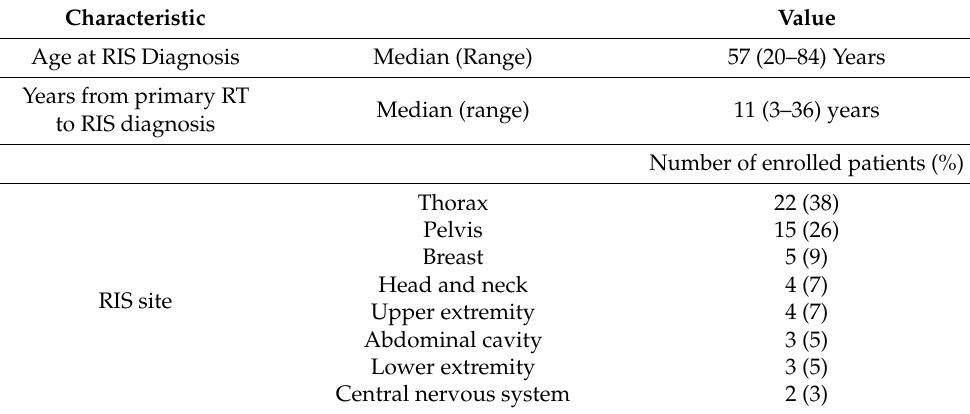
Table 2. Radiation-induced sarcoma